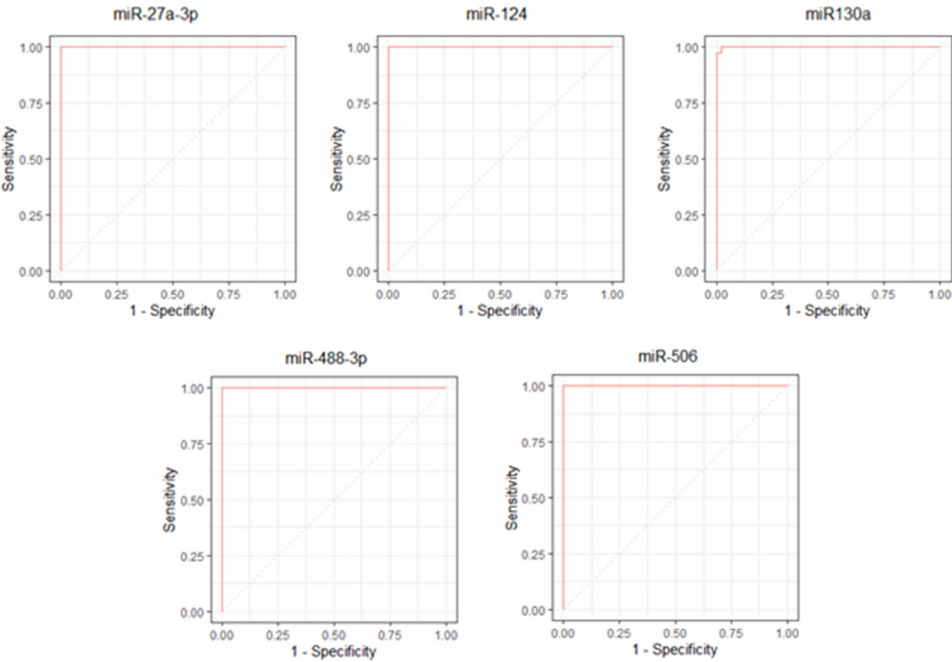
Figure 2. ROC curves for the miR-27a-3p, miR-124, miR-130a, miR-488-3p, and